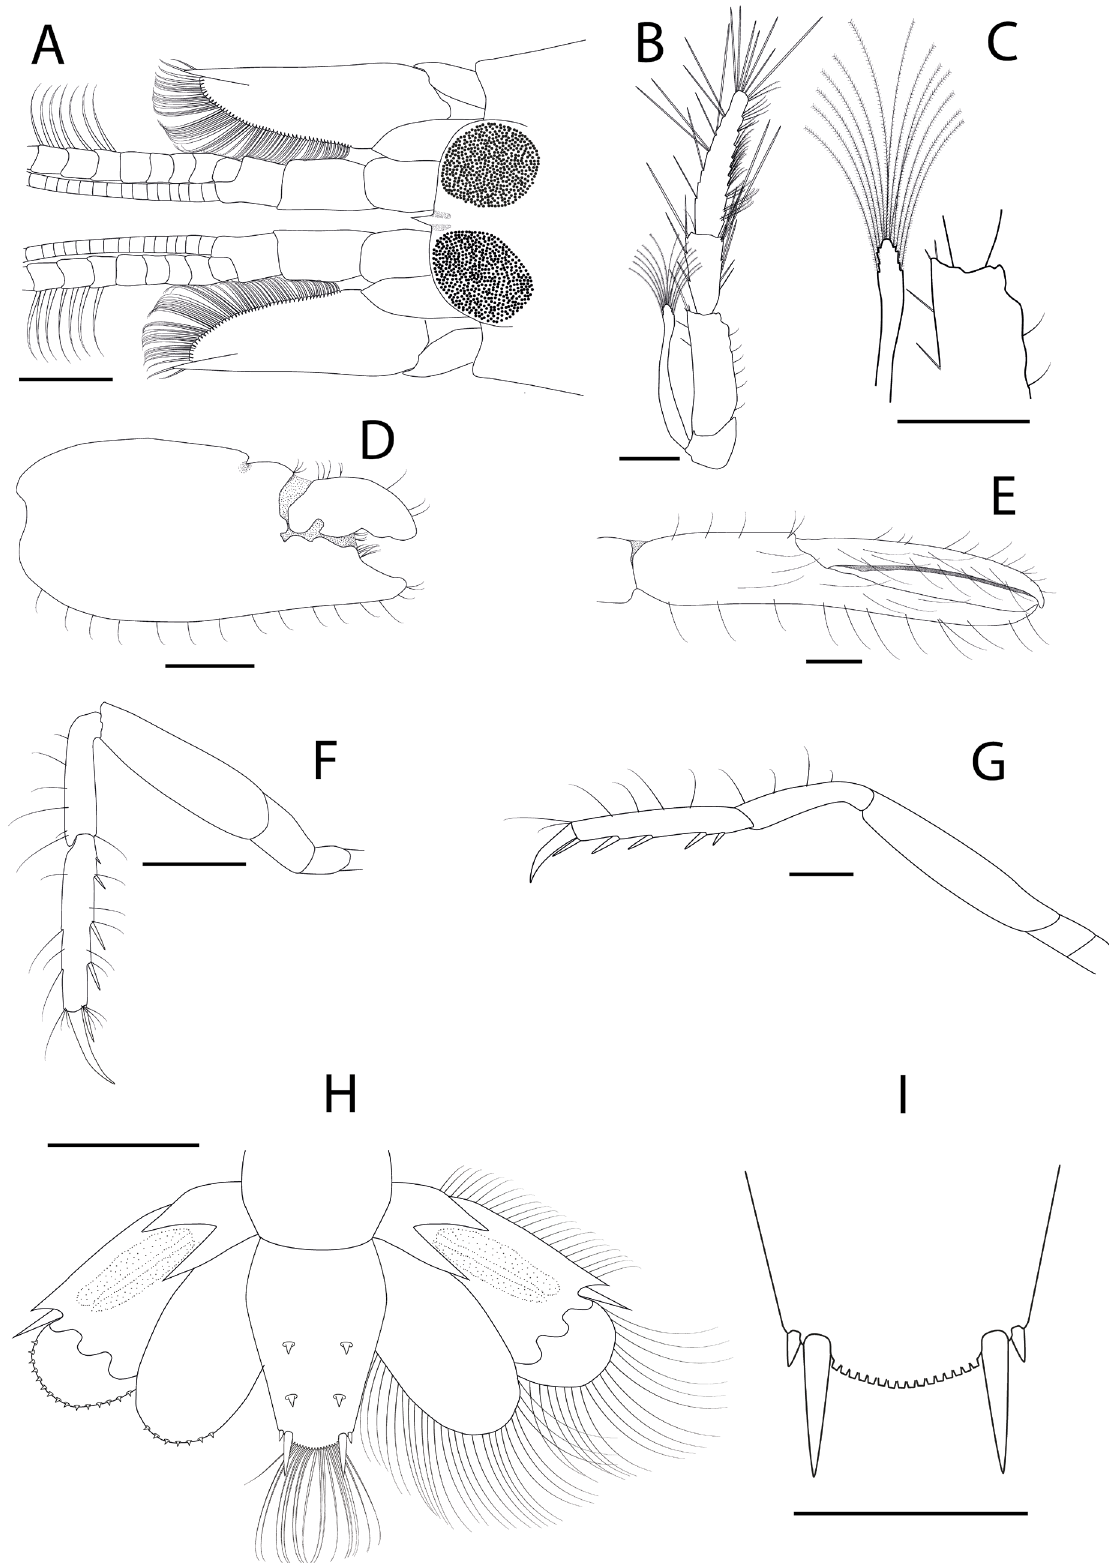
Figure 2. Alpheus christofferseni Anker, Hurt and Knowlton, 2007, male from Praia dos Carneiros, Tamandaré, Pernambuco, Brazil (DZ/UFRGS 6934): A , Frontal region and cephalic appendages, dorsal view; B , third maxilliped, lateral view; C , detail of the exopod of the third maxilliped, lateral view; D , left major cheliped, lateral view; E , right minor cheliped, lateral view; F , third pereiopod, lateral view; G , fourth pereiopod, lateral view; H , telson and uropod, dorsal view; I , same, detail of posterior margin. Scale bars: A , D , F , H , I = 1 mm; B , C, E, G = 0.5